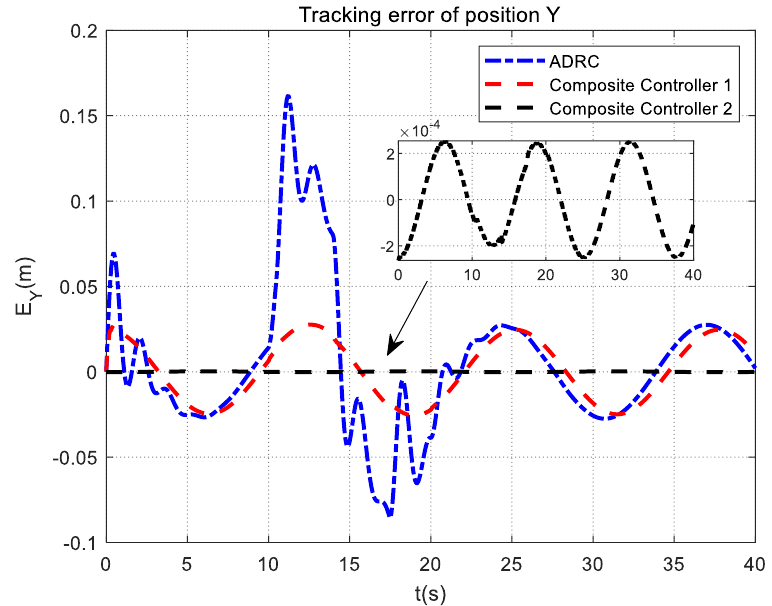
Figure 13. Tracking error of position Y control for QUAV under actuator constant fault and disturb- ance condition.